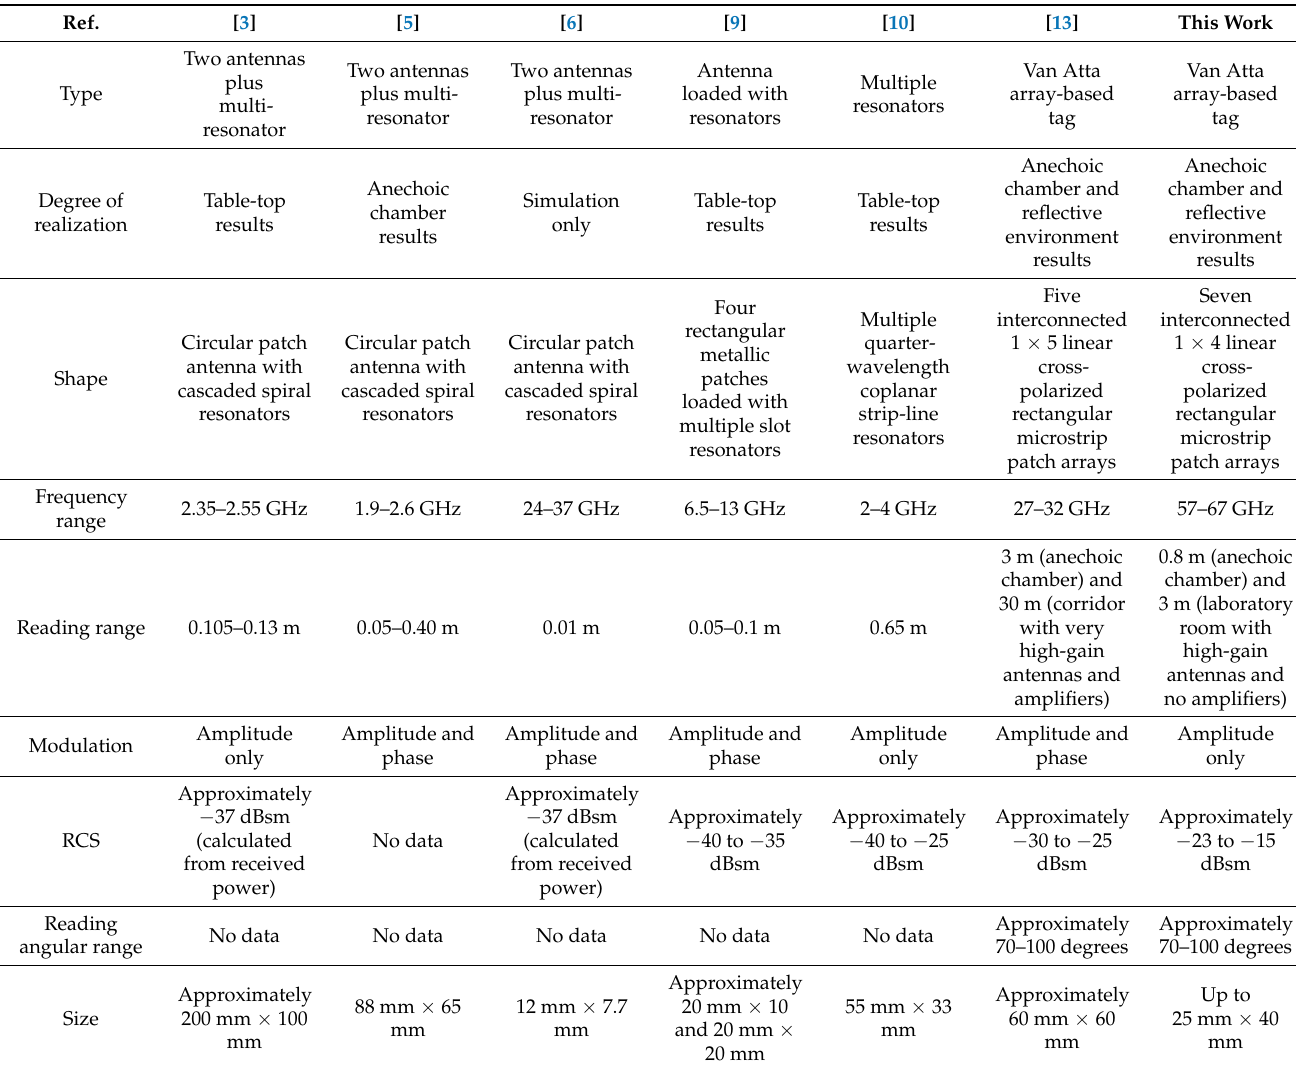
Table 4. Comparison of the presented Van Atta array tags with state-of-the-art chipless RFID tags.